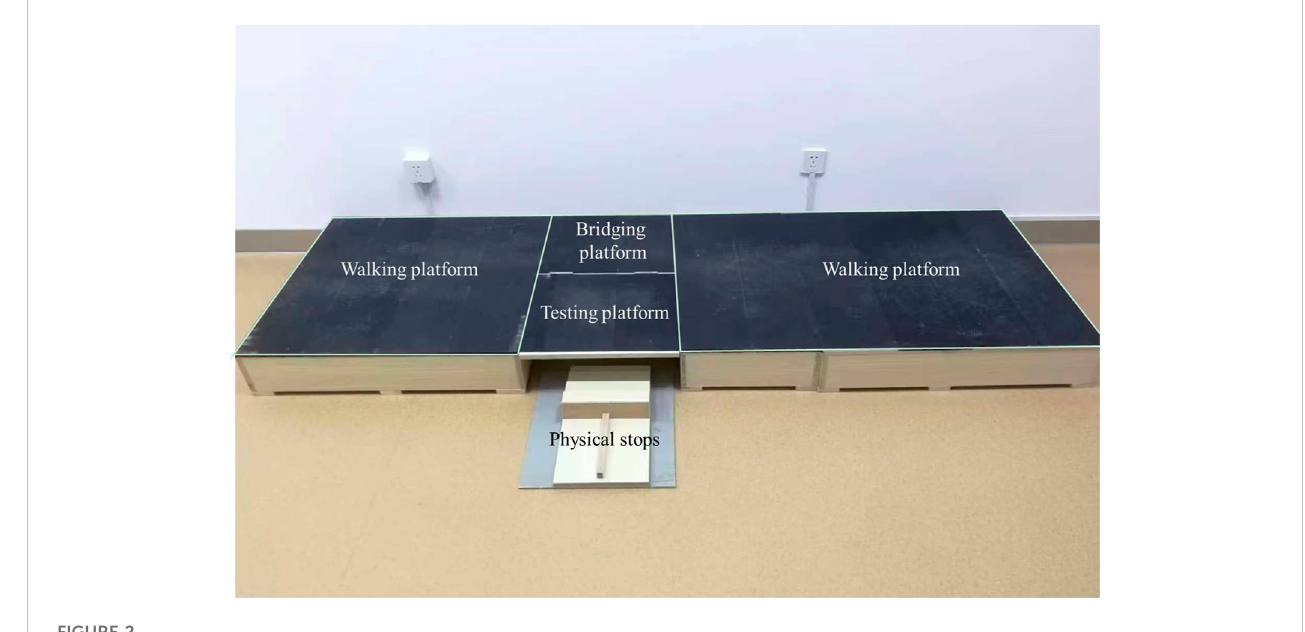
The genuine picture of AIDAW.